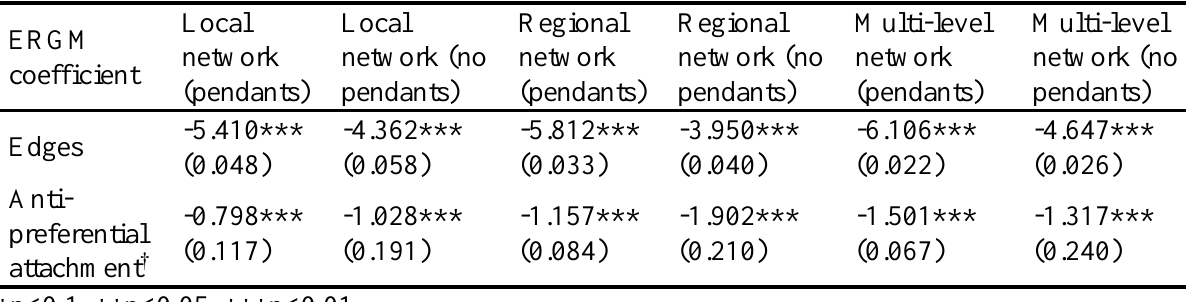
Table A1.2: ERGM results illustrating the effects of removing pendants on the coefficient for anti-preferential attachment, in the absence of any other endogenous or exogenous model terms